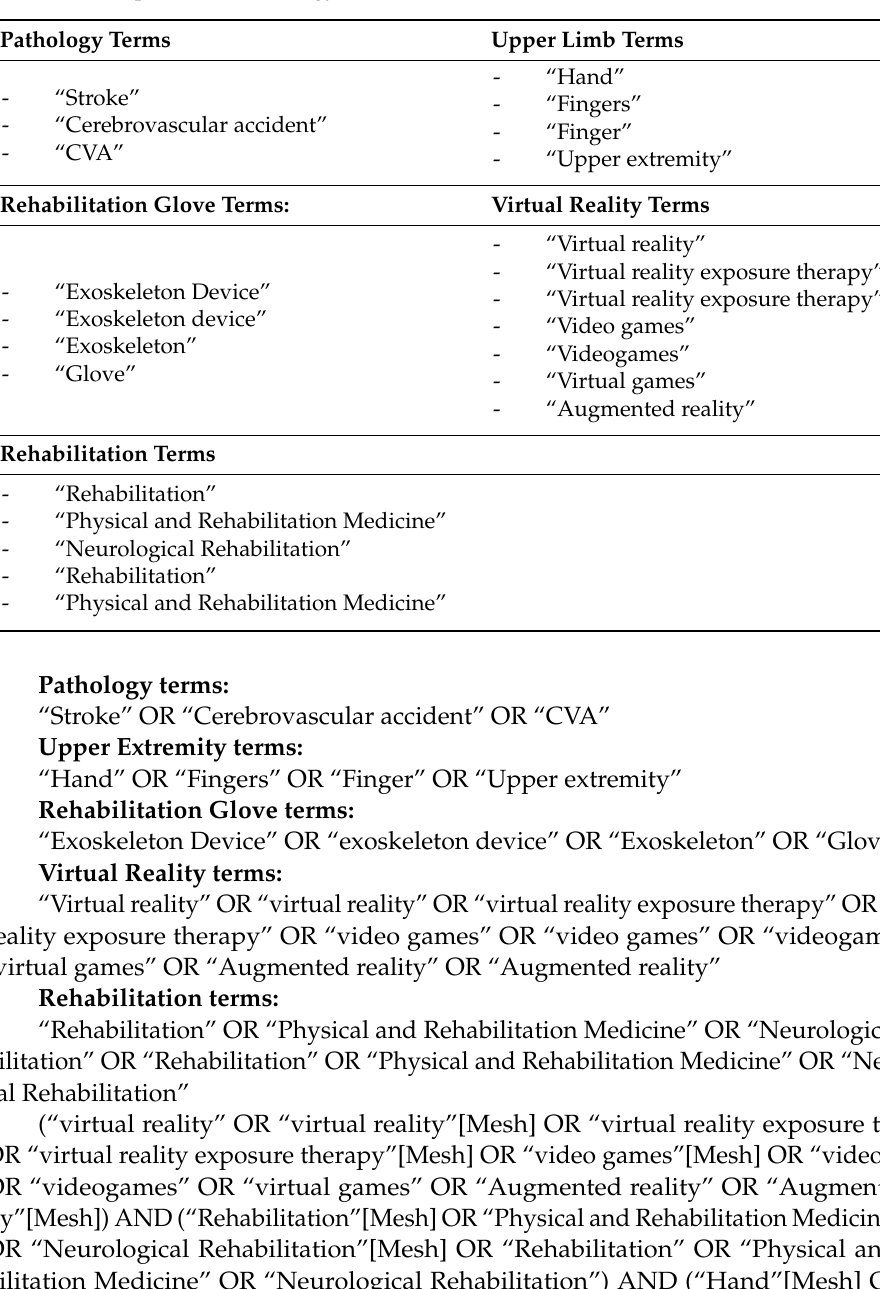
Table A1. Complete search